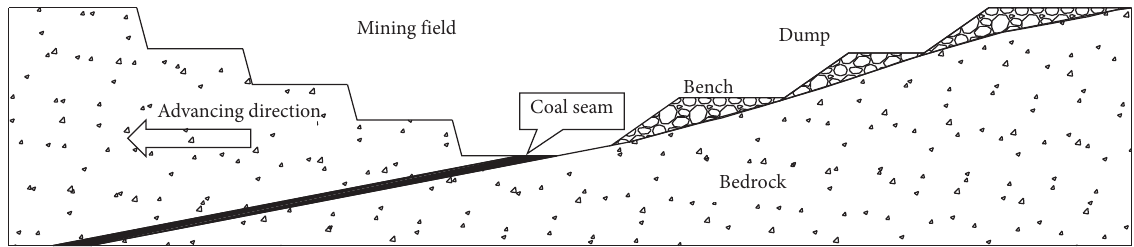
Figure 1: The method of dump at the zone with large dip angle.